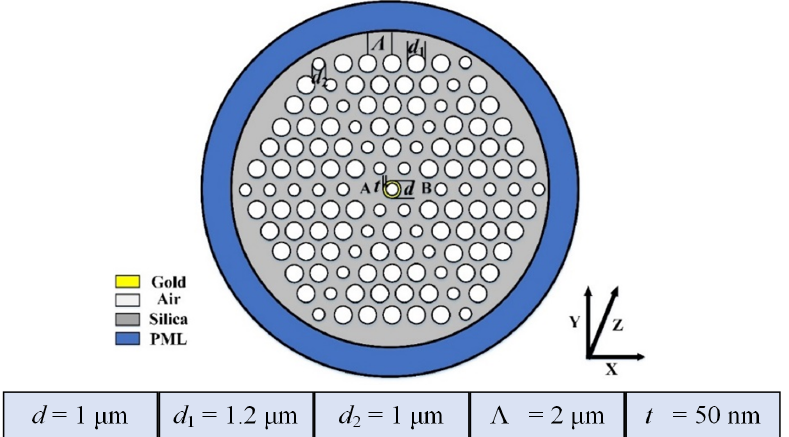
Figure 1. A sectional view of the proposed DCPCF with its structual parameters, d , d 1 , d 2 , Λ , and t .